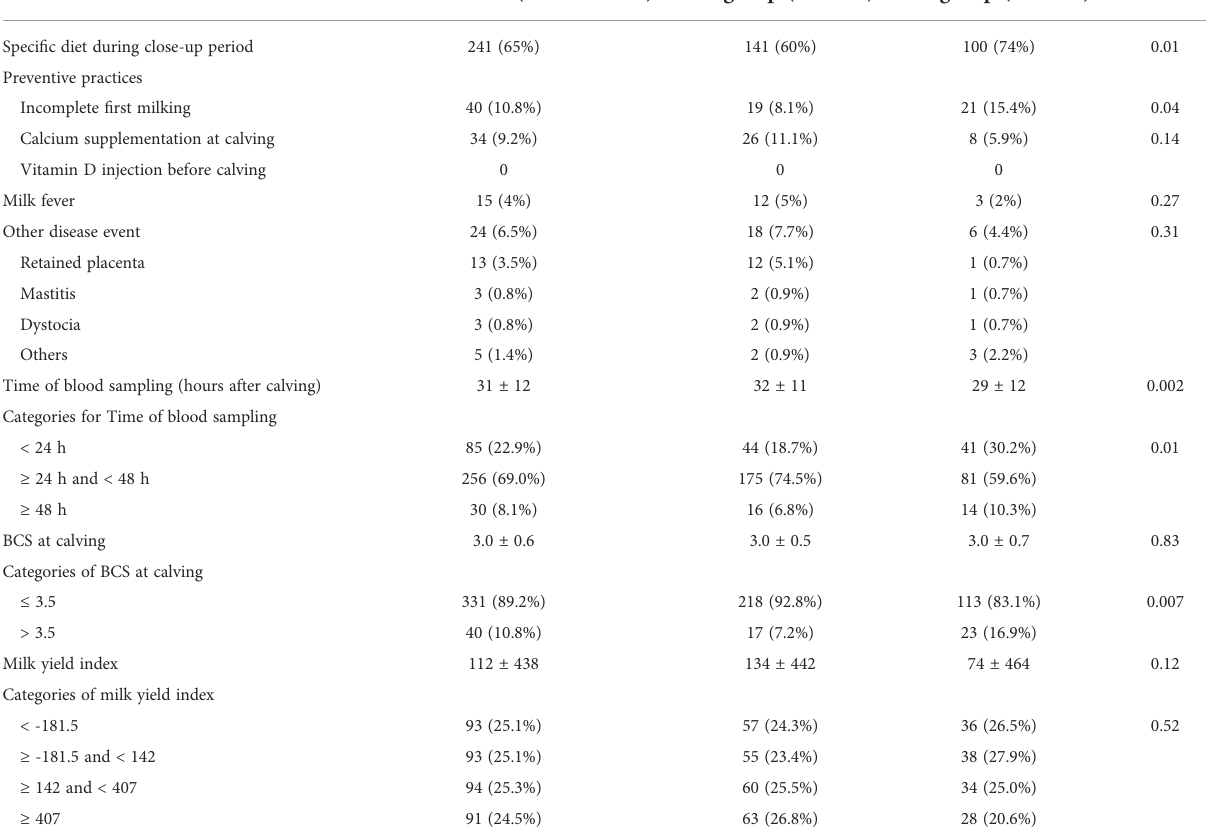
TABLE 4 Description of cow characteristics tested for inclusion in the subclinical hypocalcemia (SHC) and subclinical hypophosphatemia (SHP) models. Variables were measured as part of a cohort study of 371 dairy